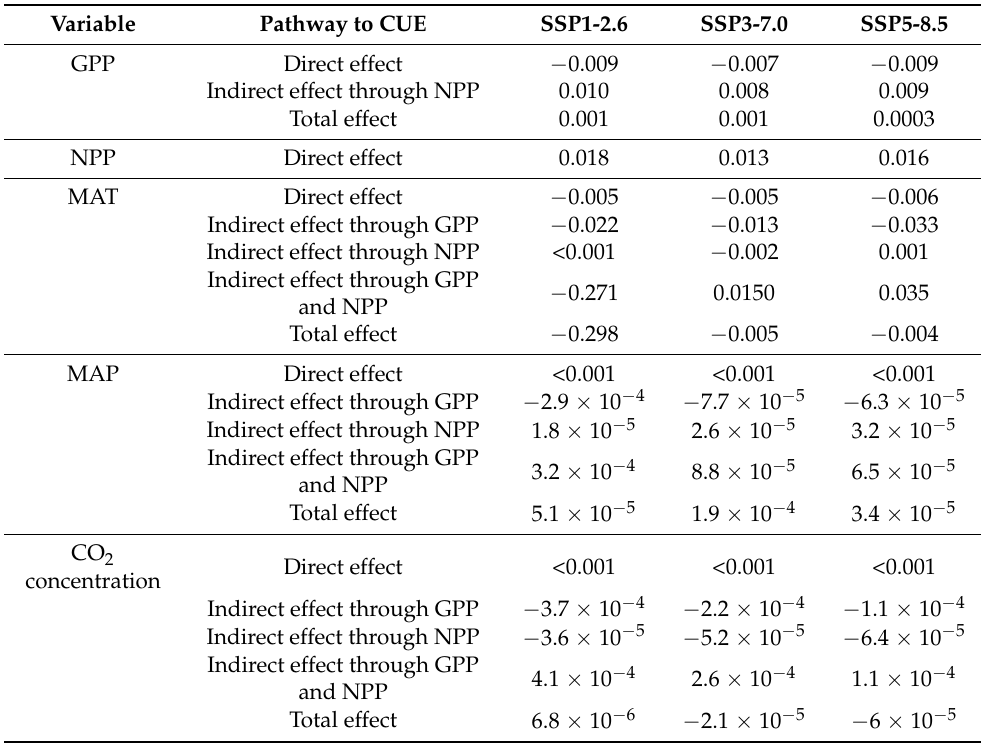
Table A2. The direct, indirect and total standardized effects on CUE based on structural equation models